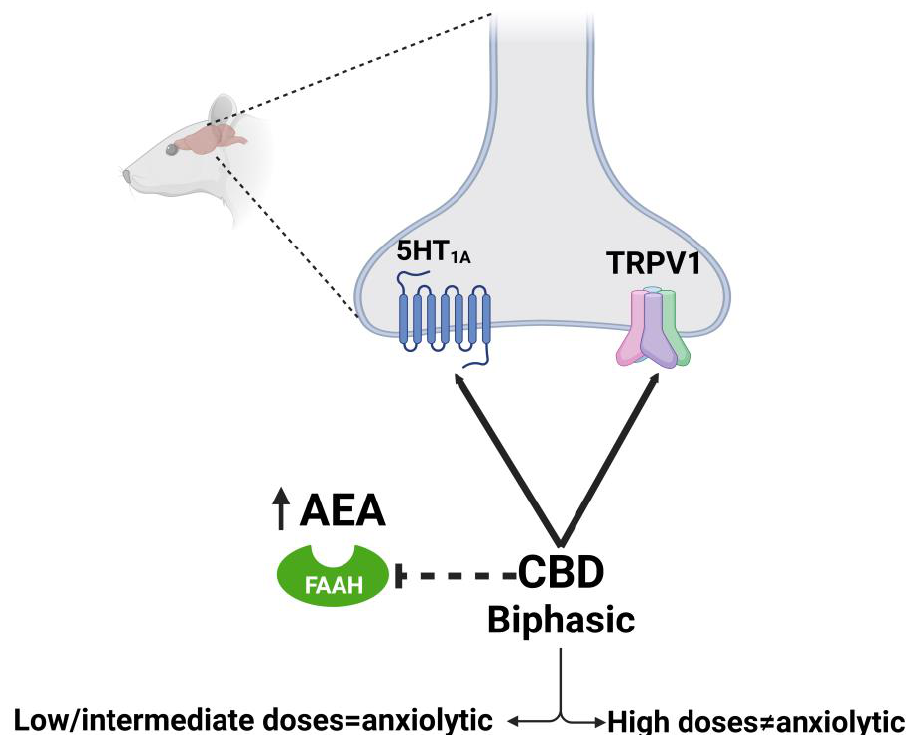
Figure 5. Molecular mechanism of CBD on anxiety described in rat model. Dotted lines refer to hypothesized mechanisms. Created with Biorender.com.